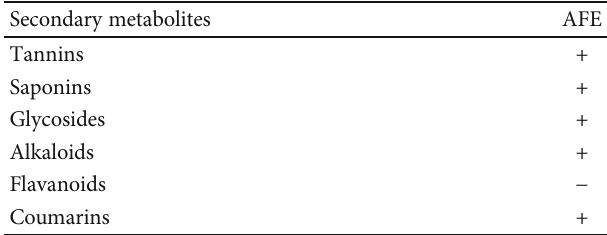
Table 1: Phytochemical screening of AFE. Secondary metabolites AFE Tannins + Saponins +